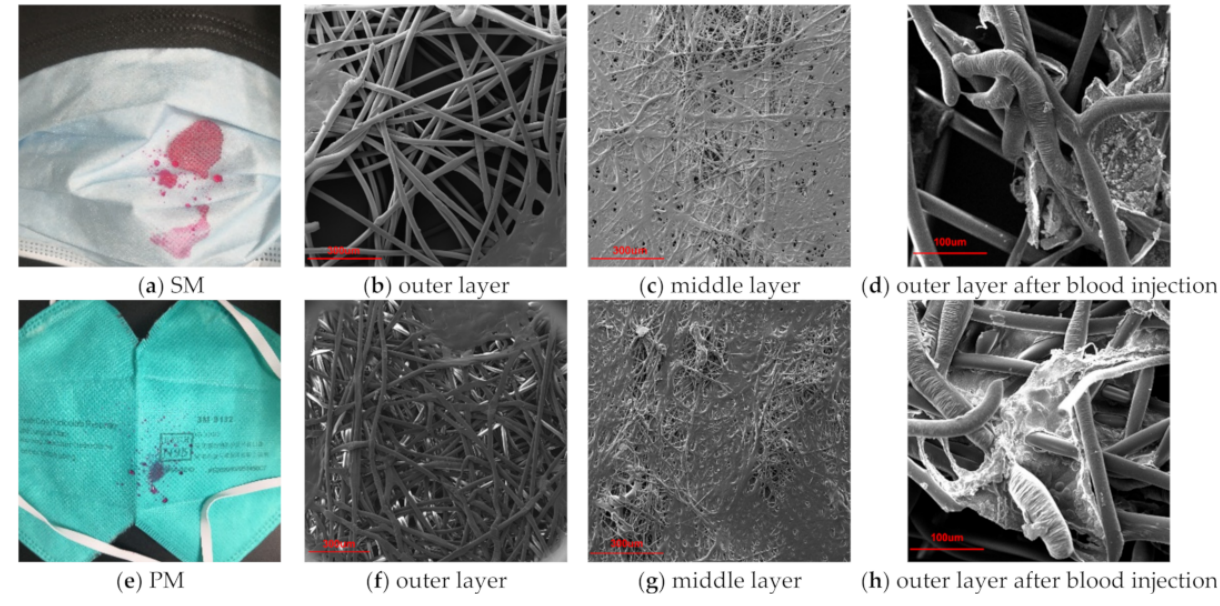
Figure 5. Surface morphology of the mask after blood injection.